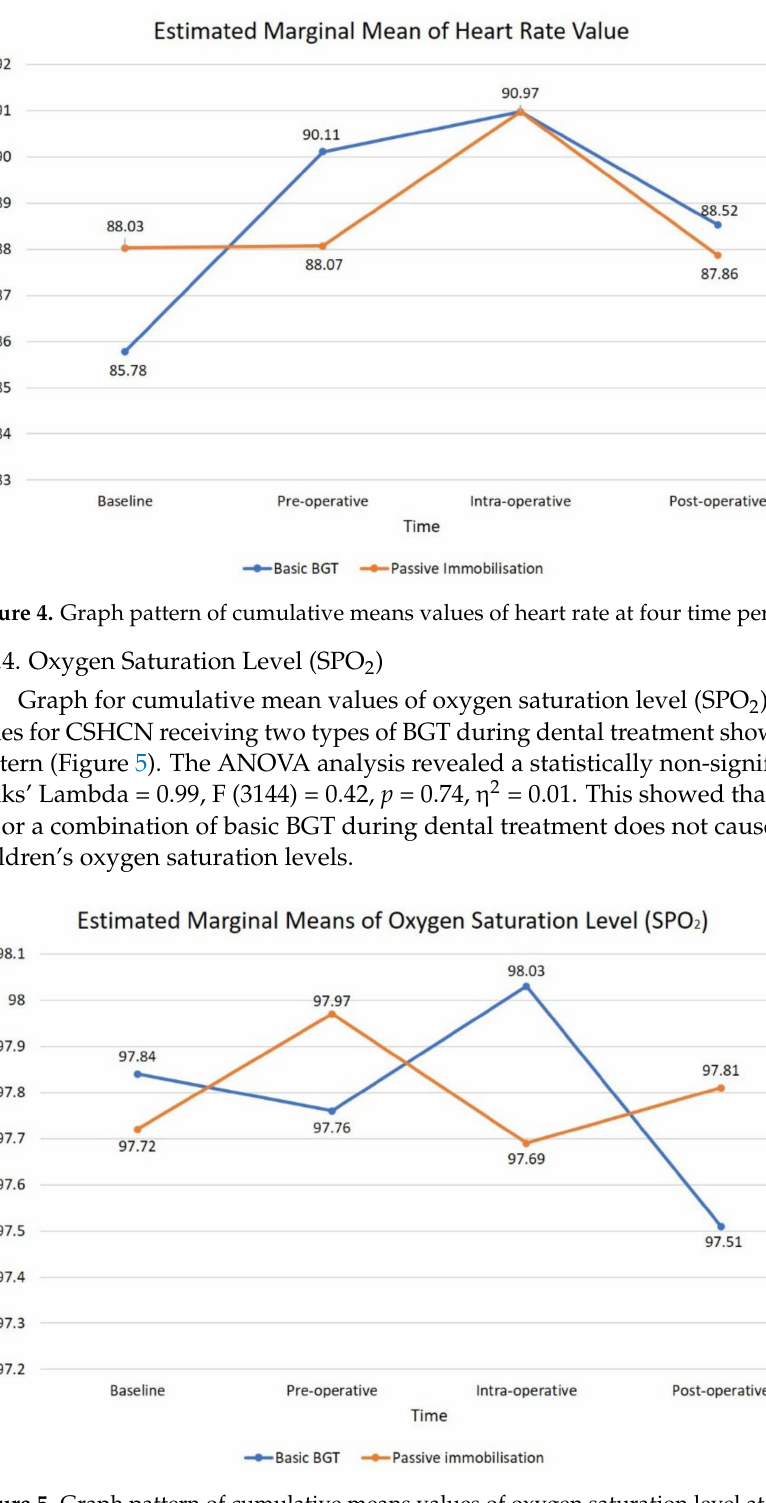
Figure 5. Graph pattern of cumulative means values of oxygen saturation level at four time